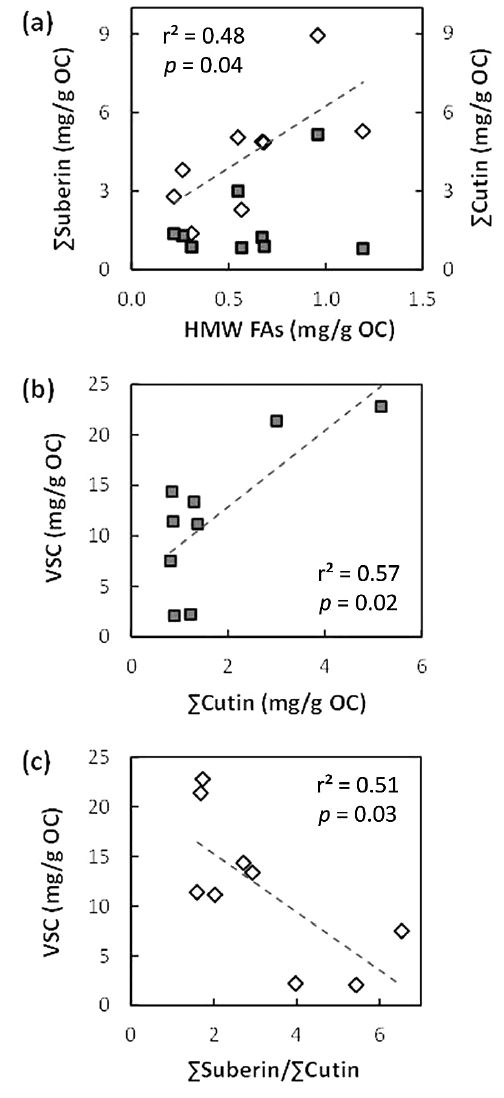
Figure 3. Correlations between the abundances of various terrestrial biomarkers in the pan-Arctic sediments. Open diamonds and filled squares in (a) represent suberin ( P Suberin) and cutin ( P Cutin) biomarkers, respectively (contents defined in Table 3). HMW FAs: high-molecular-weight fatty acids (C 20 -C 30 ) . VSC: vanillyl, sy- ringyl and cinnamyl lignin phenols.